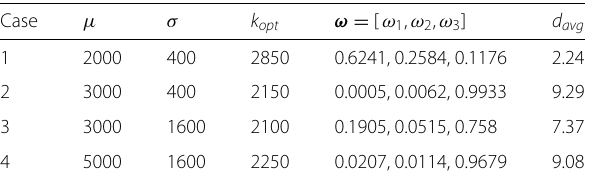
Table 2 Optimal code length k opt and weighting vector ω over the MDEC with a non-negative Gaussian distributed channel